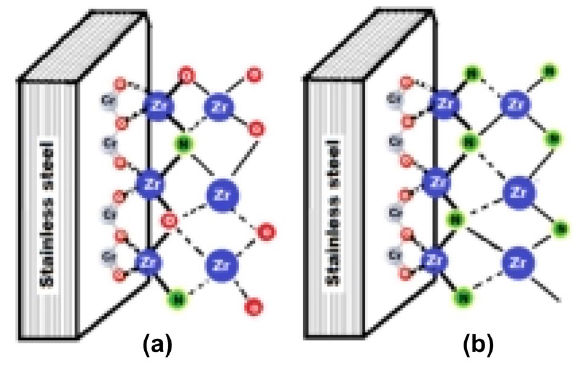
Figure 12. Schematic representation of the substrate-coating interaction forces. ( a ) ZrO 2 -ZrO x N y ( b ) ZrN- ZrO